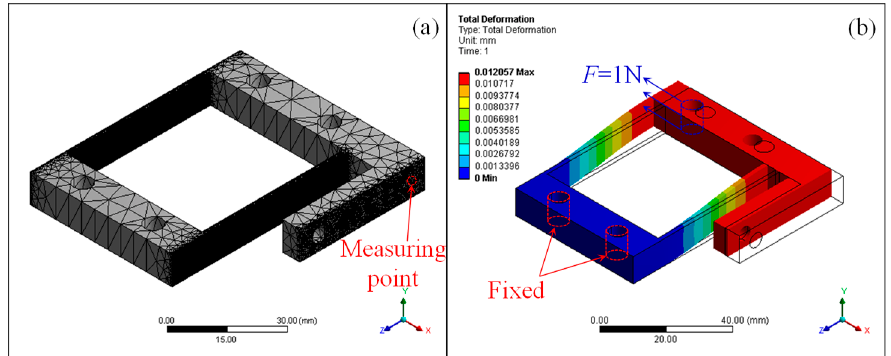
Figure 5. Finite element analysis of the flexure parallel mechanism using the designed model: ( a ) mesh model; ( b ) boundary conditions and results of deformation.